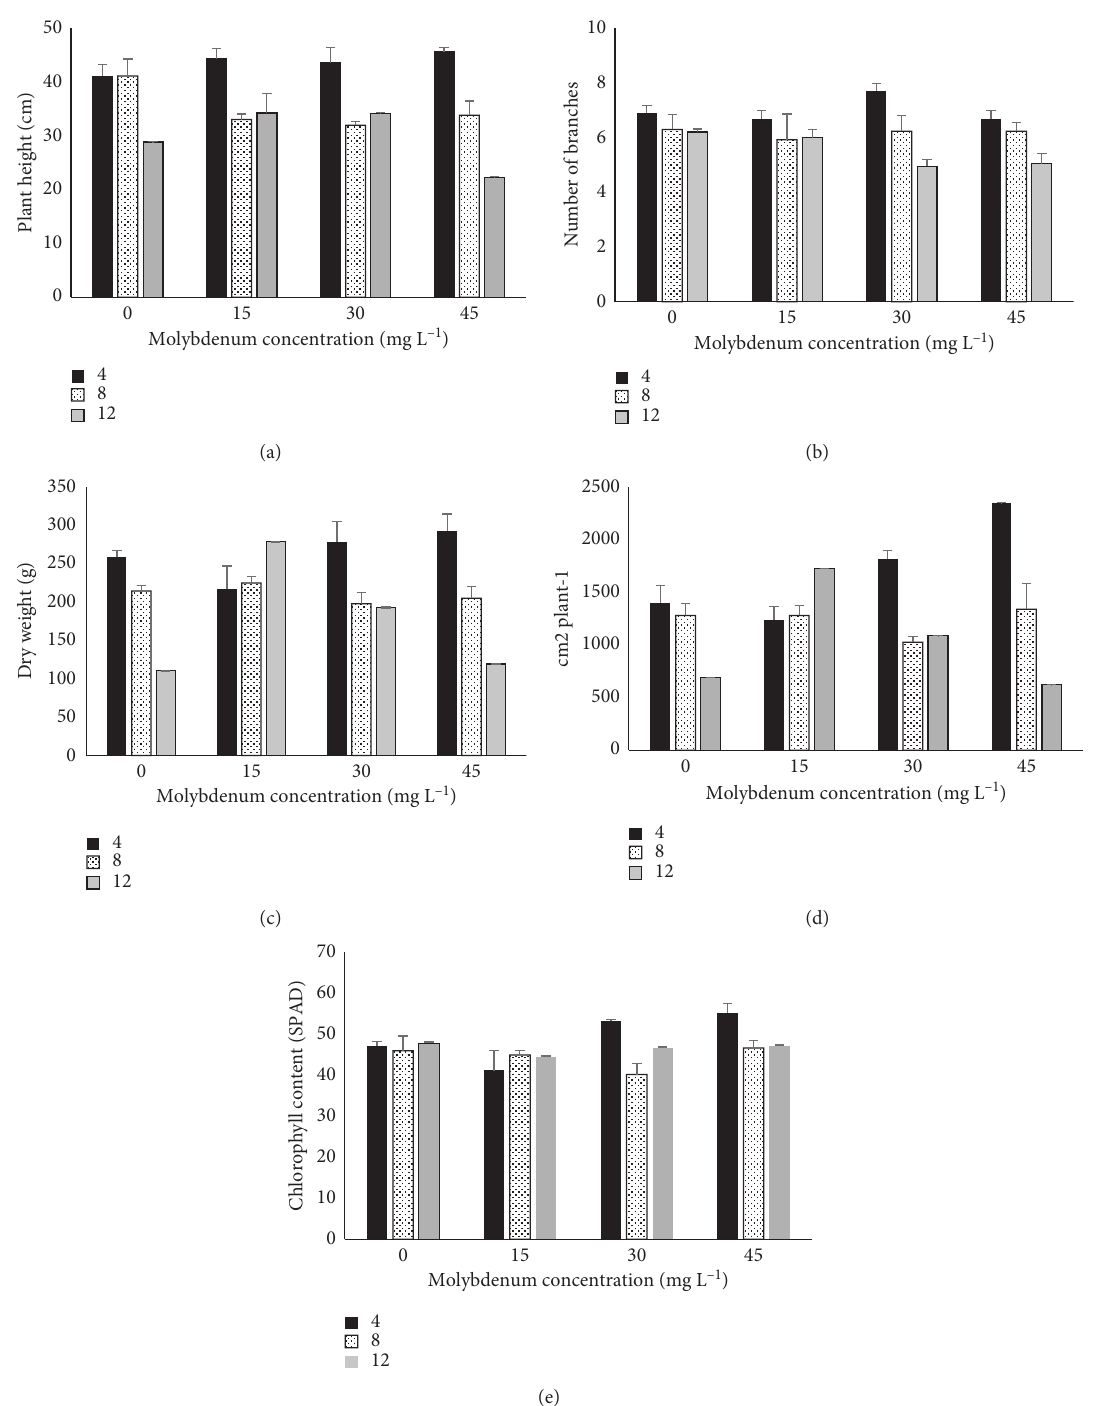
Figure 1: The effect of molybdenum treatment on growth parameters. (a) Plant height (cm) p > 0 . 0006, (b) number of branches p > 0 . 0006, (c) dry weight (g) p > 0 . 0003, (d) leaf area (cm 2 plant − 1 ) p > 0 . 00003, and (e) chlorophyll content (SPAD), p > 0 . 004 of mung FW at the control treatment to 499.33 mg · g − 1 · FW at the highest concentration of Mo (45 mg · L − 1 ). The baseline activities of the antioxidant en- zymes increased significantly with the increase of Mo concentration (Table 4).